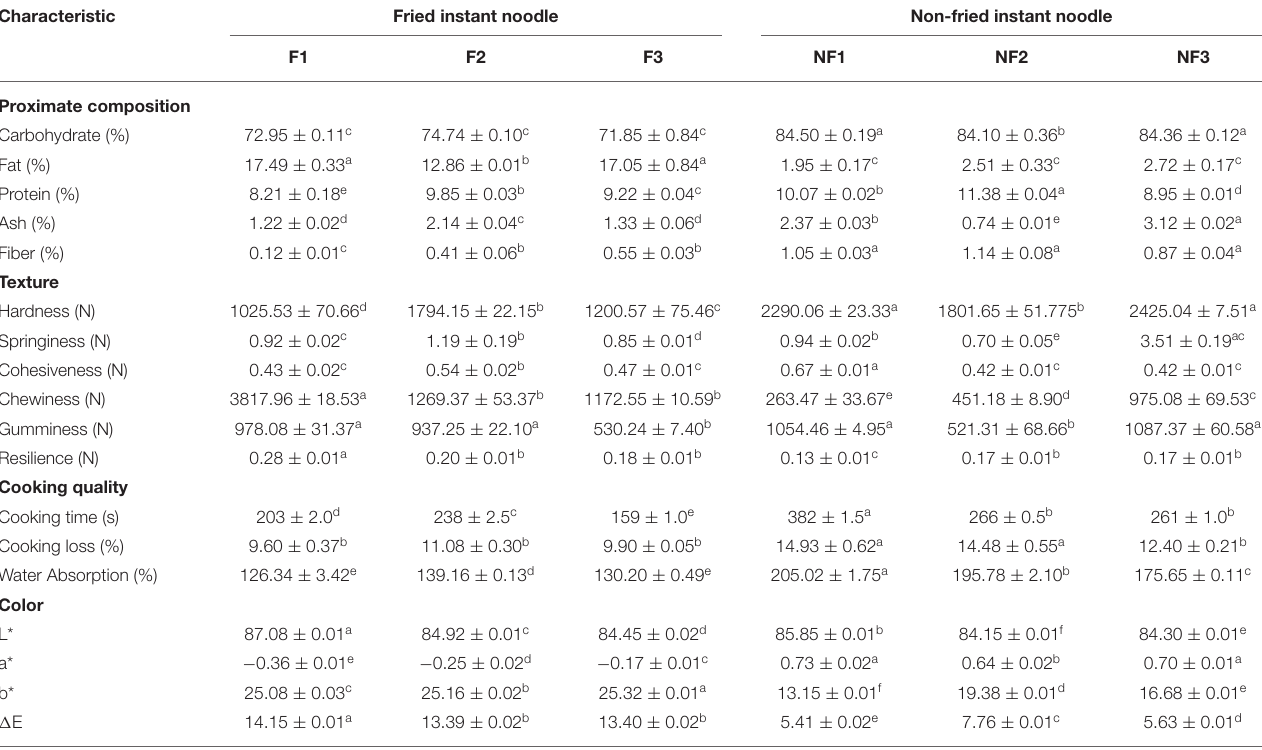
TABLE 2 | Quality evaluation of fried and non-fried instant noodle (dry basis). Characteristic